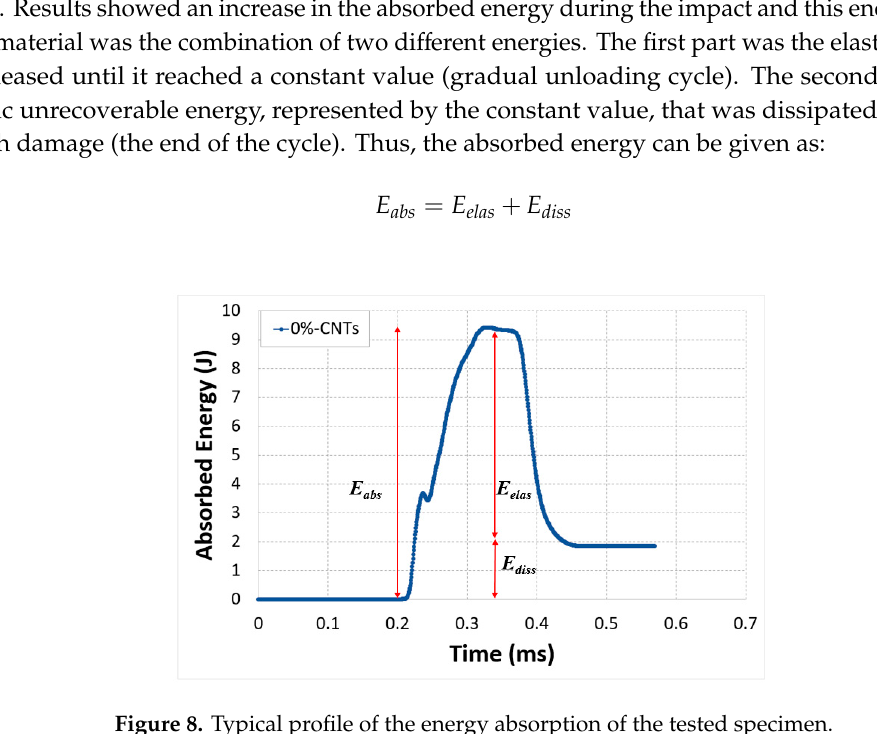
Figure 8. Typical profile of the energy absorption of the tested specimen.